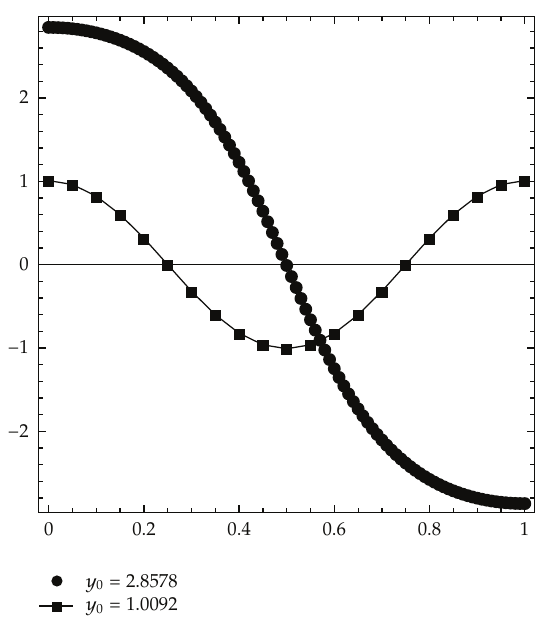
Figure 4: Solution of (cid:2) 1.2 (cid:3) corresponding to the initial values y 0 for 4 π 2 ≤ λ (cid:5) 45 < 9 π 2